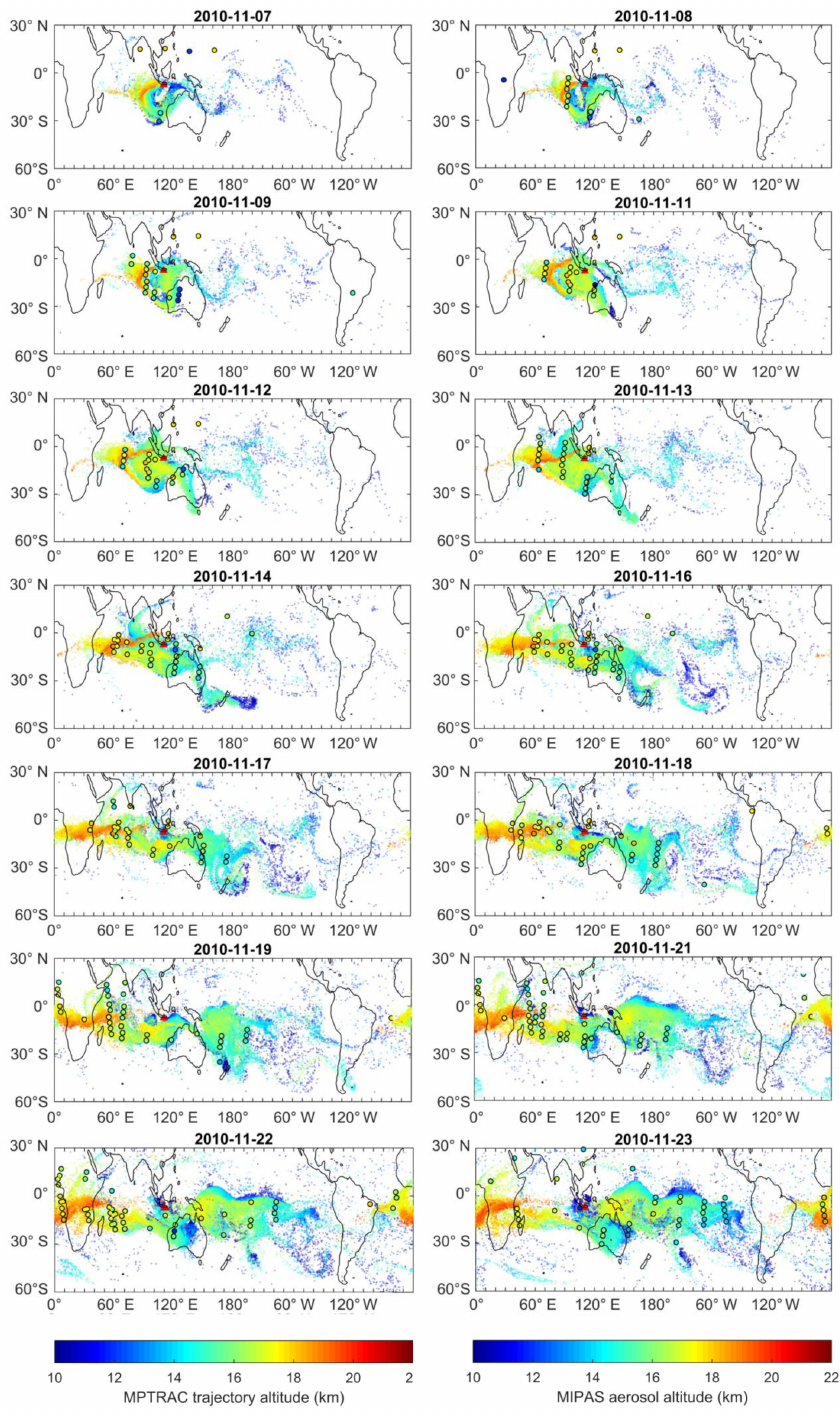
Figure 3. Distribution of the volcanic plume (showing only air parcels higher than 10km, shading) from MPTRAC simulations (shown for 00:00UTC on selected days) and MIPAS aerosol detections (ACI<7) within ± 6h (color-filled circles). The altitudes of all air parcels, regardless of their SO 2 values, are shown. The red triangle denotes the location of Mount